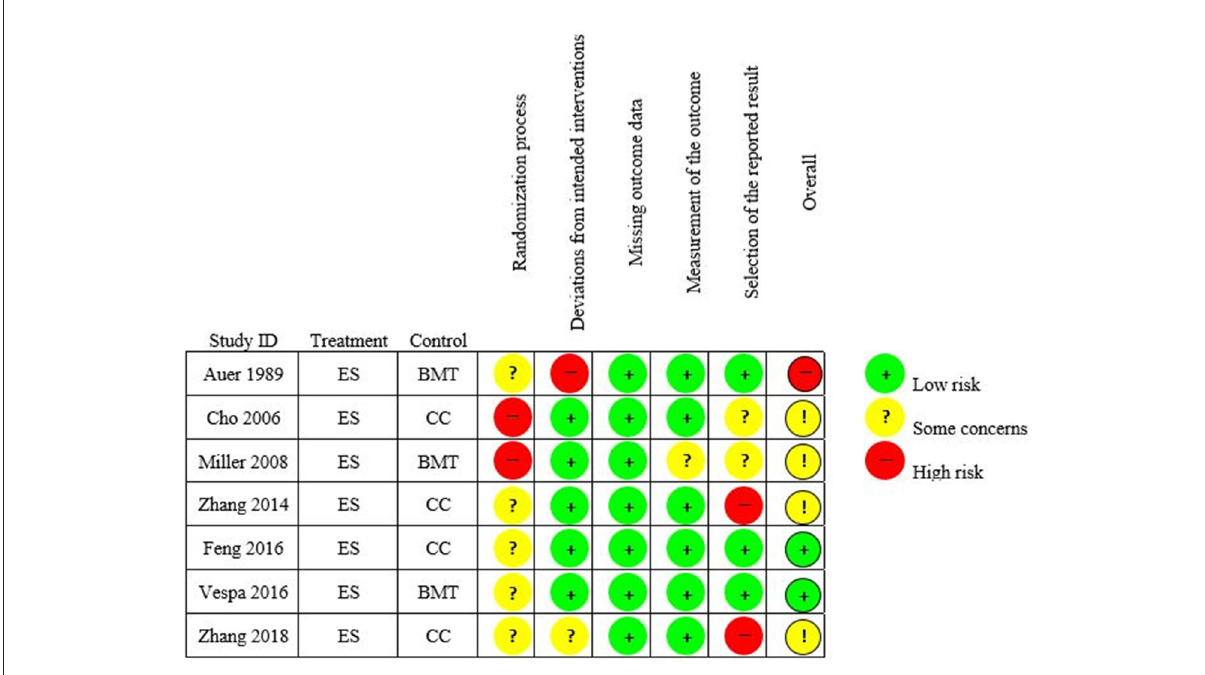
FIGURE3 Risk of bias analysis (Rob-2) traffic light plot for the included